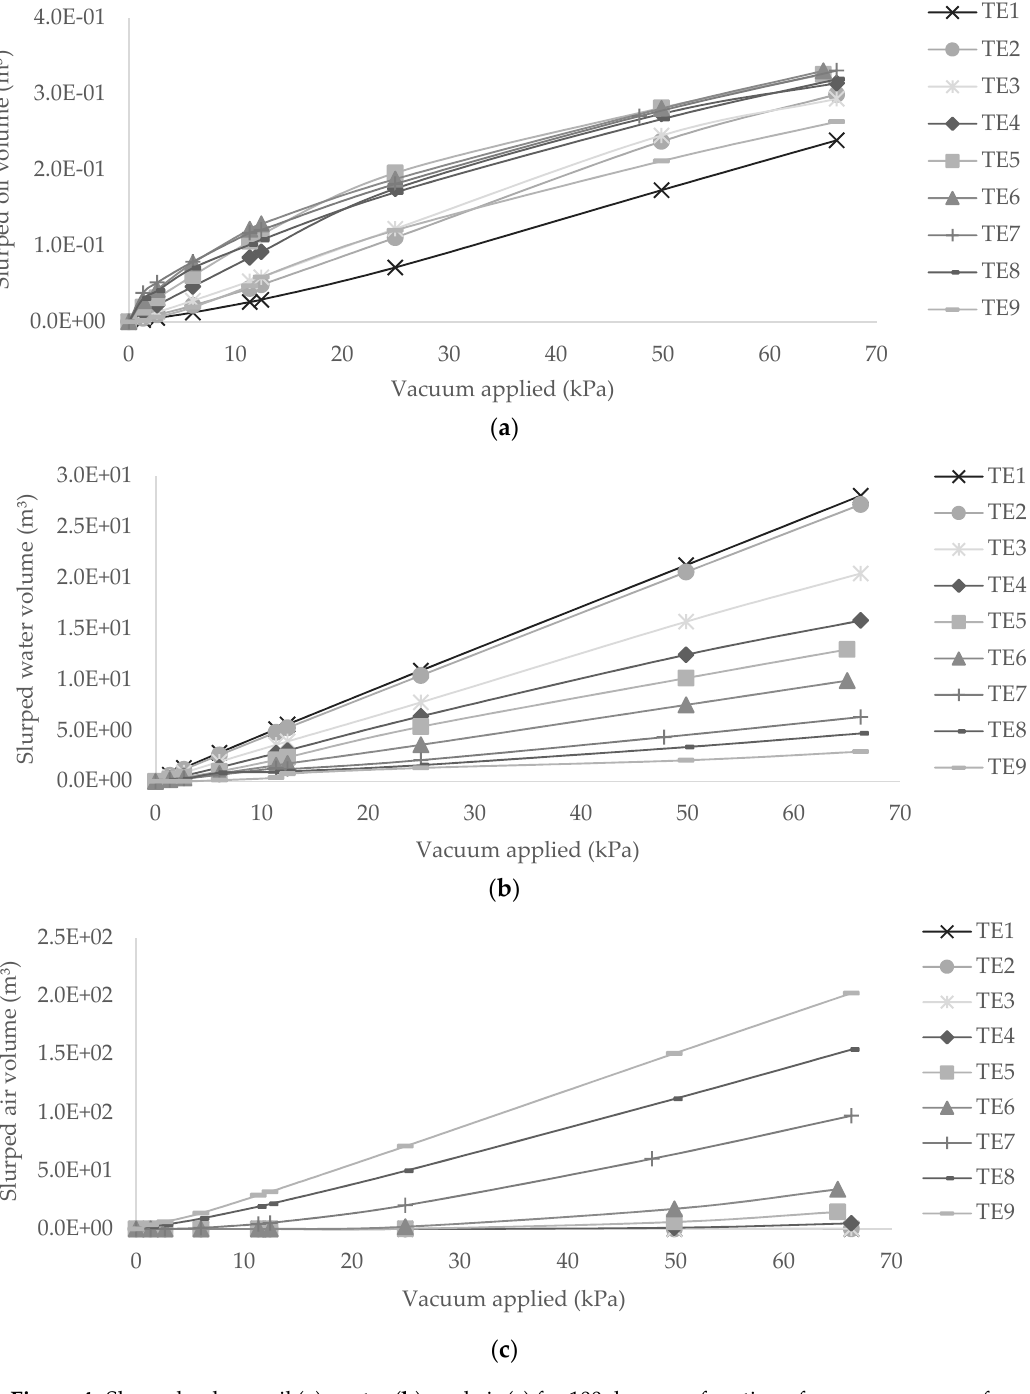
Figure 4. Slurped volume oil ( a ), water ( b ), and air ( c ) for 100 days as a function of vacuum pressure for extraction depending of the slurping tip tube positions z (TE1 = 6.85, TE2 = 7.05, TE3 = 7.25, TE4 = 7.55, TE5 = 7.75, TE6 = 7.95, and TE7 = 8.25 m) located in water (TE1), oil–water interface (TE2), oil (TE3, TE4, TE5, TE6, and TE7), air–oil interface (TE8), and air (TE9) in silty sand.